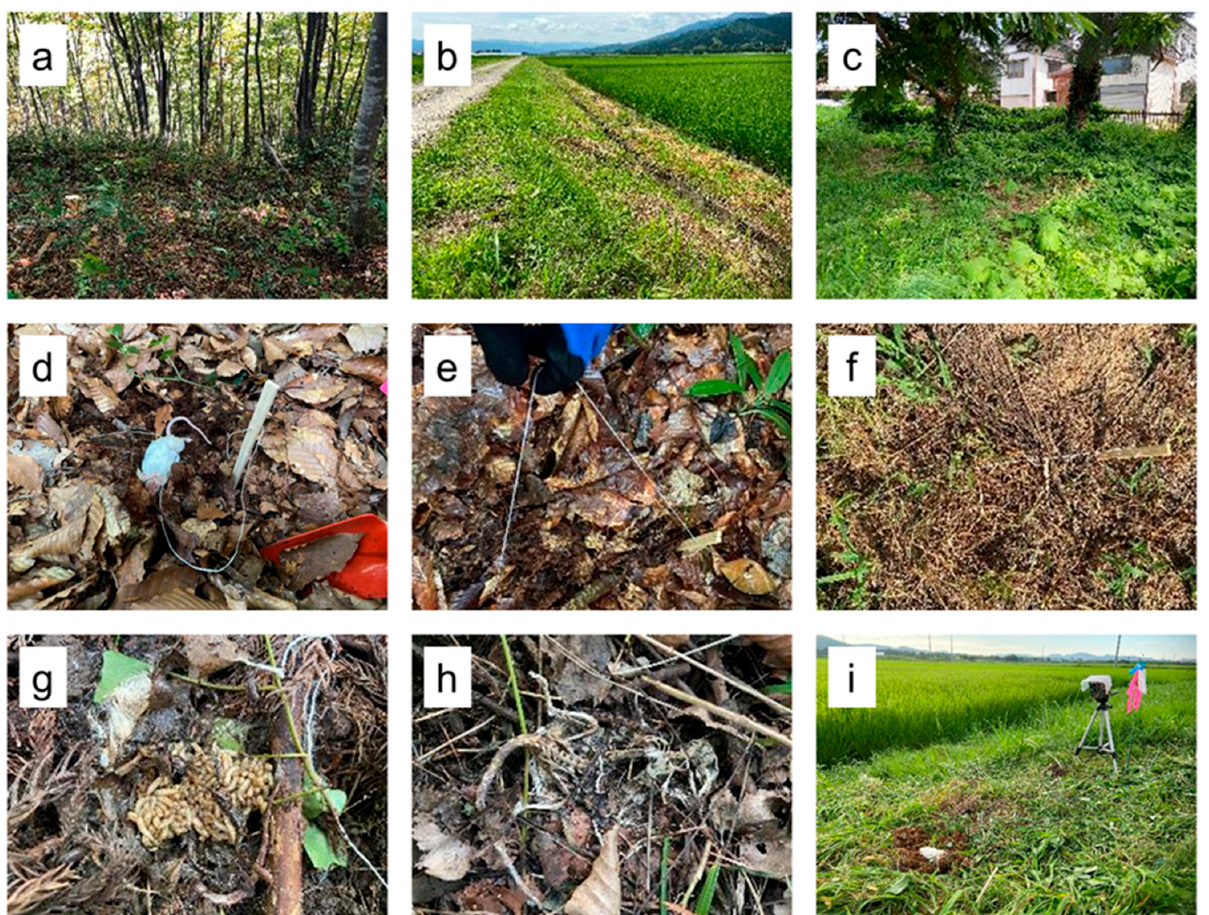
Figure 2. Photographs related to field survey. ( a ) An example of forest-closed sites, ( b ) an example of agricultural are-open sites, ( c ) an example of urban-closed sites, ( d ) a small carcass placed for field experiments, ( e ) removal of a carcass by vertebrates, ( f ) burial of a carcass by Nicrophorus beetles, ( g ) colonization of a carcass by flies, ( h ) colonization of a carcass by ants, ( i ) a camera trap in agricultural are-open sites.